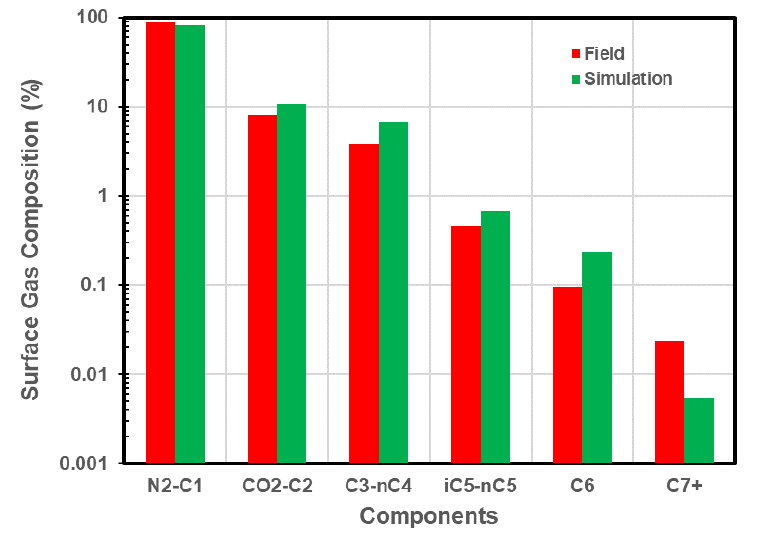
Figure 9. Surface gas compositions: field vs. simulation model prediction. A reasonable match of the field data was achieved. Table 3. Reservoir properties derived from the best-case simulation numerical model history match.